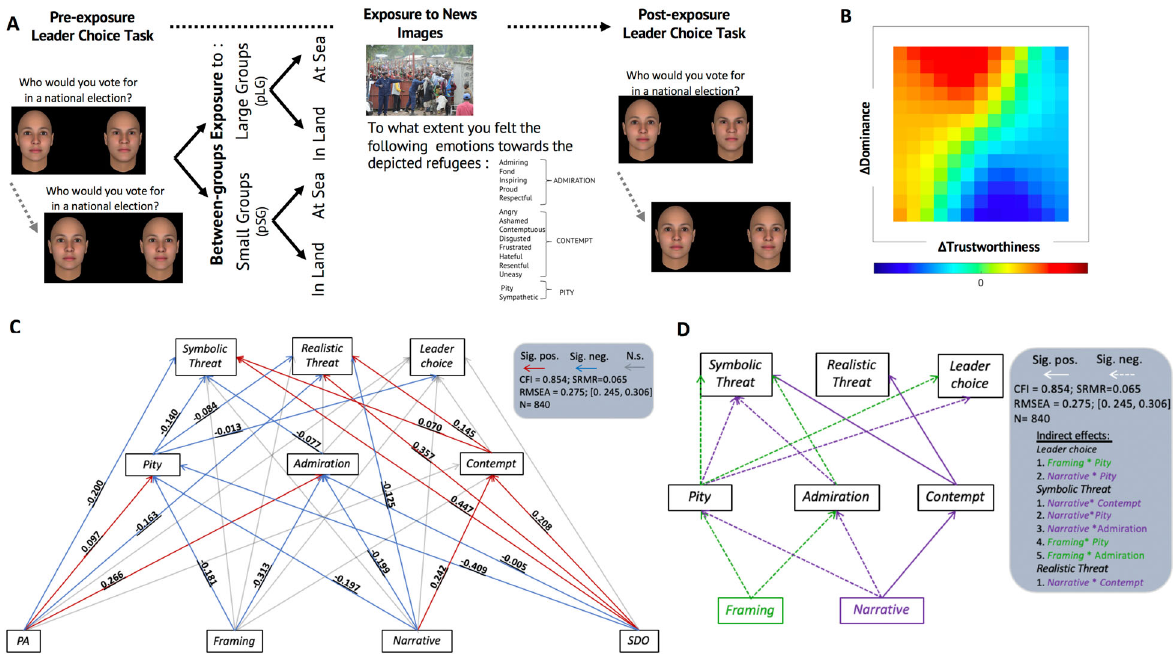
Fig. 6 Experimental design of study 8 and results. A Between-subjects design of Study 8. Before and after exposure to images, participants completed a leader-choice-task. During exposure (16 images of refugees pLG/pSG; Land/Sea) participants rated after each image, to what extent they felt 15 emotions towards the depicted refugees (VAS scale; 0 — not at all — 100 — very much so). Pity toward refugees was calculated as the average of two items (pity and sympathetic); Admiration as the average of fi ve items (admiring, fond, inspiring, proud, respectful) and contempt as the average of eight items (angry, ashamed, contemptuous, disgusted, frustrated, hateful, resentful, and uneasy). B Heatmaps for the change (post minus pre) in probability of choosing a face as a leader according to perceived Trustworthiness and Dominance. C Structural equation model predicting Leader-Choice and symbolic and realistic threat. Standardized parameter estimates are shown in blue for negative and red lines for positive signi fi cant relationships. PA = Political attitude, conservative-liberal (0 – 7); Framing = pSG(0), pLG(1); Narrative = sea(0), land(1); SDO = Social Dominance Orientation) Political Leader Choice (Post – Pre exposure to images of refugees). D Plot of signi fi cant indirect effects of Framing (green) and Narrative (purple) on Leader-Choice behaviour, perceptions of symbolic and realistic threat via felt Emotions (Pity, Admiration, and Contempt) towards refugees. Signi fi cant negative paths are plotted in dotted and signi fi cant positive paths in solid lines. All indirect effects presented positively predict the manifest variables Leader-Choice, Symbolic and Realistic threat; i.e. both pLG and images on Land are positively related to socio-political variables via the respective emotions (see also Table S3 in Supplementary